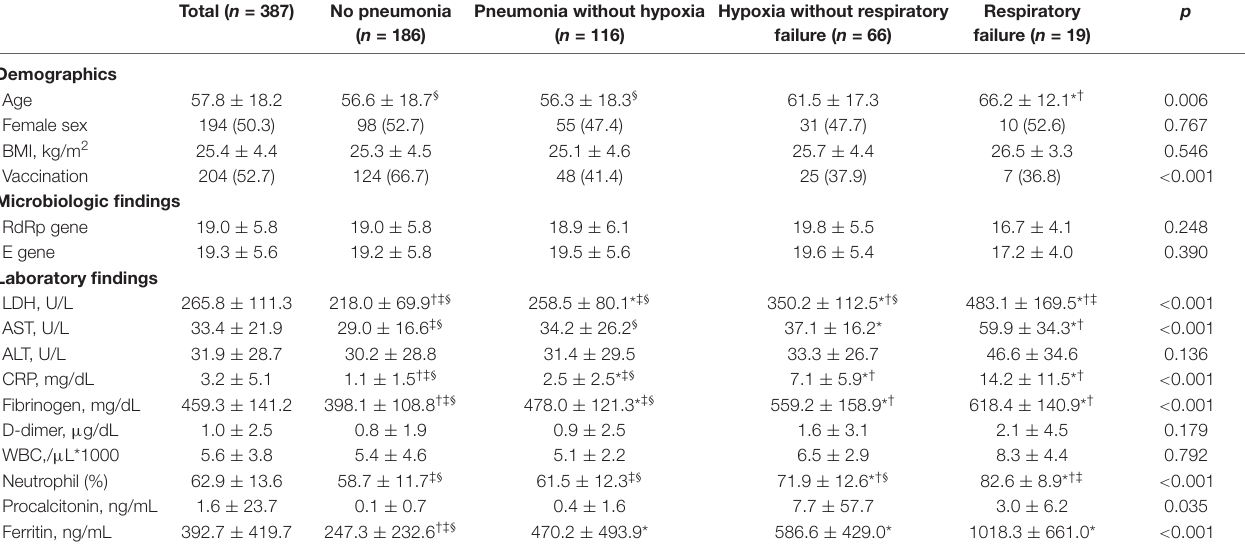
TABLE 1 | Characteristics of COVID-19 patients stratified by severity.